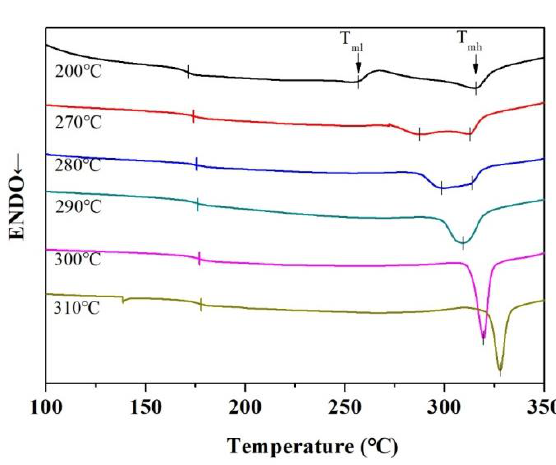
Figure 10. XRD patterns of BT@ZnPc-GO-1/PEN nanocomposite films with 15 wt % BT@ZnPc-GO-1 after isothermal annealing at 200, 270, 280, 290, 300 and 310 °C for 2 h.